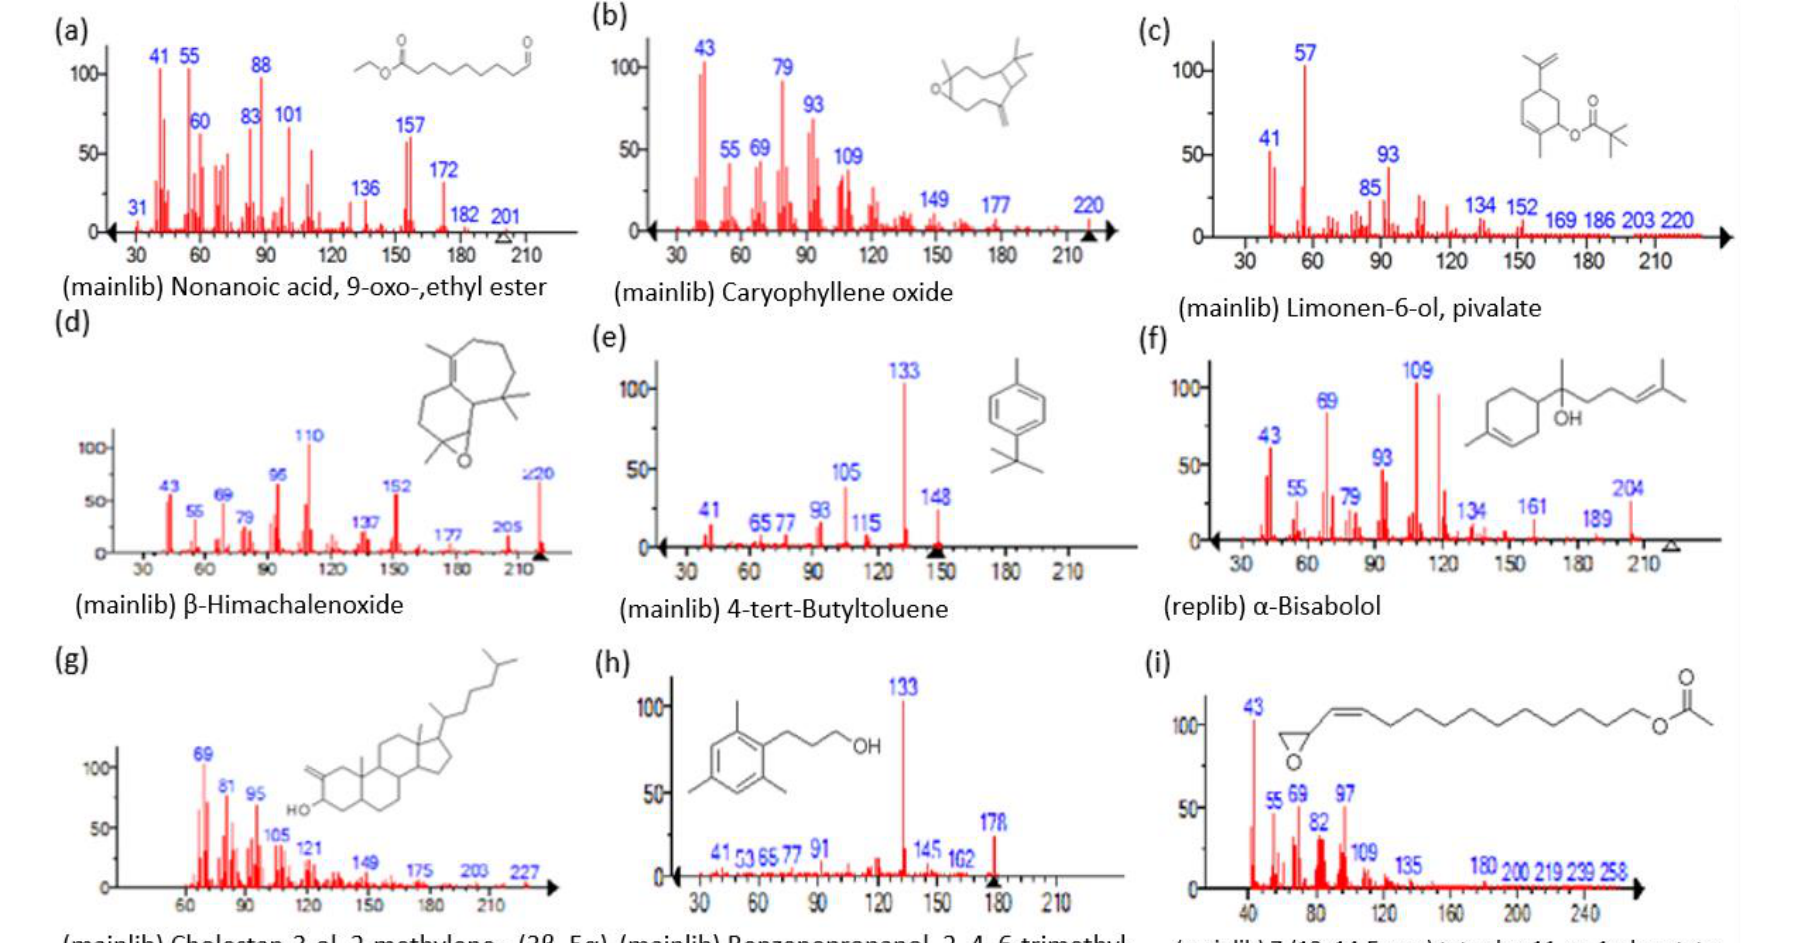
Figure 3. Representing the mass spectrum of Nonanoic acid, 9-oxo-, ethyl ester with RT= 33.692 ( a ), Caryophyllene oxide with retention time (RT) =35.706 ( b ), Limonen-6-ol, pivalate with RT = 36.06 ( c ), β - Himachaleoxide with RT = 36.39 ( d ), 4-tert-Butyltoluene with RT = 36.853 ( e ), α -Bisabolol with RT = 37.276 ( f ), Cholestan-3-ol, 2-methylene-, (3 β , 5 α ) with RT = 36.325 ( g ), Benzenepropanol, 2, 4, 6-trimethyl- with RT =36.942 ( h ), and Z-(13,14-Epoxy) tetradec-11-en-1-ol acetate with RT = 36.613 ( i